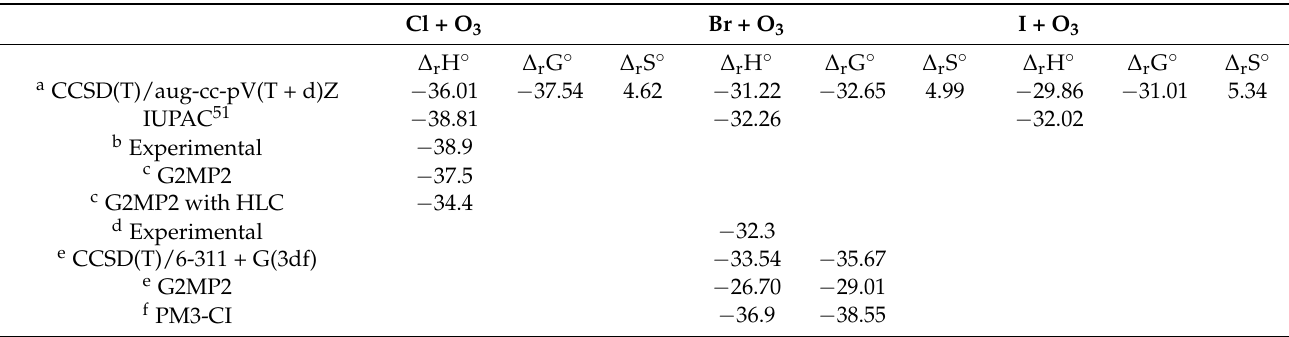
Table 10. Enthalpies ( ∆ r H ◦ , kcal mol − 1 ), Gibbs free energies ( ∆ r G ◦ , kcal mol − 1 ) and entropies ( ∆ r S ◦ , cal mol − 1 K − 1 ) for the reactions of O 3 with Cl, Br, and I atoms obtained at various levels of theory along with the reported values in the literature at 298 K.